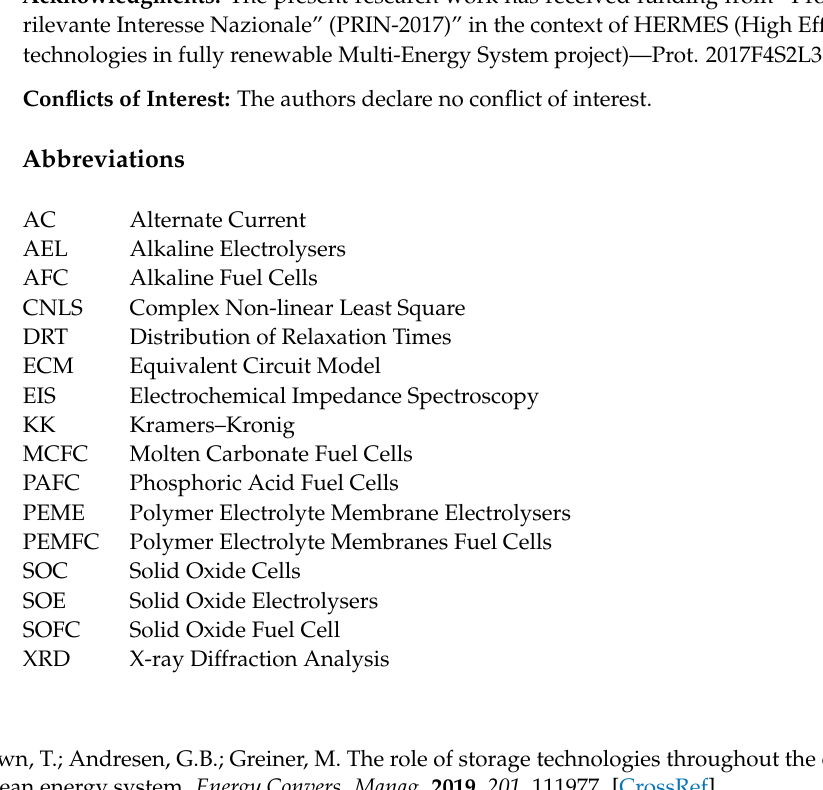
Figure S4. Sum of squared residuals vs. λ value